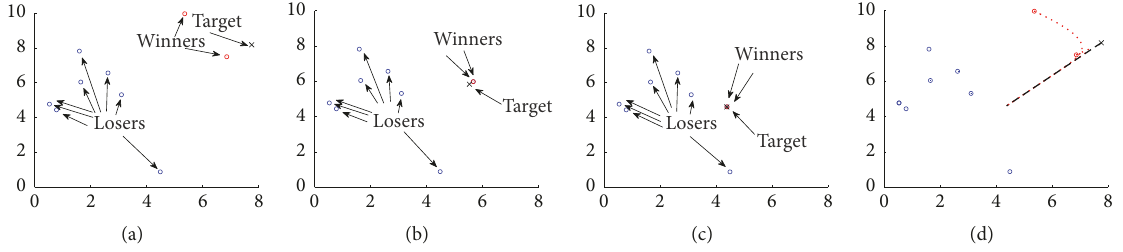
Figure 5: ( Phase 2 ) As the continuation of simulation results shown in Figure 4, this figure shows the tracking trajectory and snapshots for centralized model (12) with all-to-all communications for moving target tracking and initial locations of mobile robots being the same as those in Figure 4(c) and the initial location of moving target being generated randomly. Ten mobile robots compete with each other for tracking the moving target, and only two of them with the minimum distance from the moving target (the winners) are activated to track while the rest ones (the losers) keep unmoved. (a) The snapshot at 𝑡 ≈ 4 s. (b) The snapshot at 𝑡 = 5 s. (c) The snapshot at 𝑡 = 8 s. (d) Tracking trajectories of different mobile